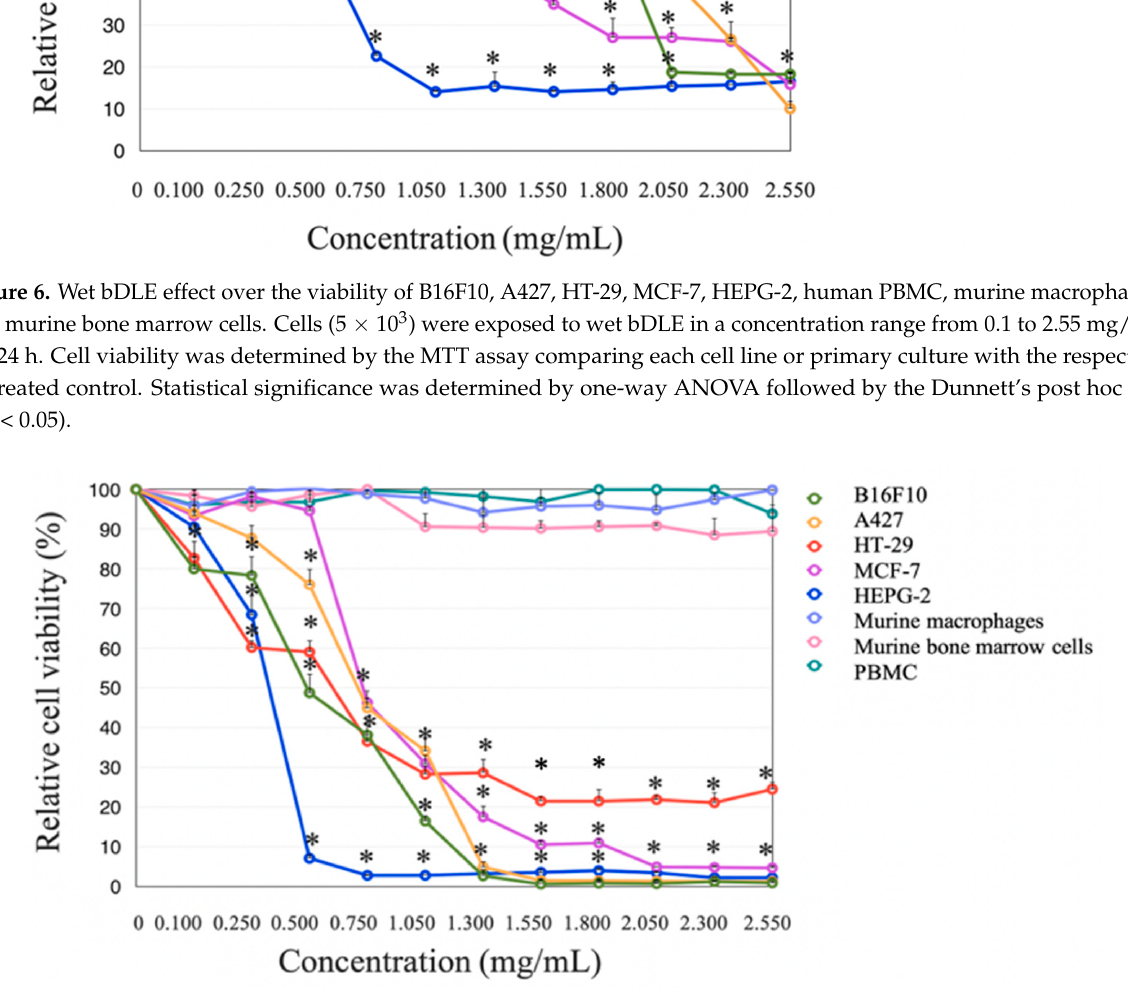
Figure 7. Dry bDLE effect over the viability of B16F10, A427, HT-29, MCF-7, HEPG-2, human peripheral blood mononuclear cells (PBMC), murine macrophages and murine bone marrow cells. Cells (5 × 10 3 ) were exposed to wet bDLE in a concentration range from 0.1 to 2.55 mg/mL for 24 h. Cell viability was determined by the MTT assay comparing each cell line or primary culture with the respective untreated control. Statistical significance was determined by one-way ANOVA followed by the Dunnett’s post hoc test (* p < 0.05).